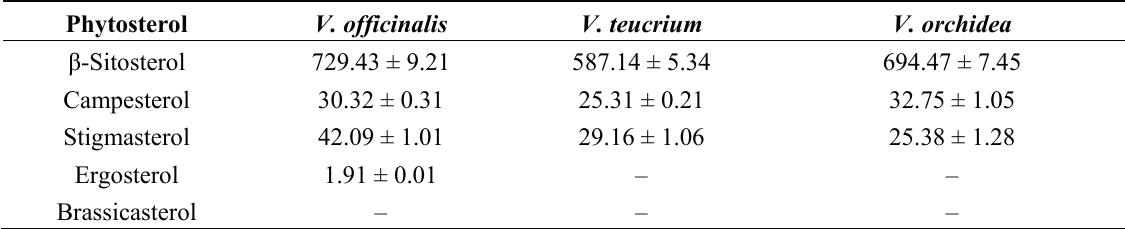
Table 5. The content in sterols ( μ g/g d.w. plant material) of Veronica species